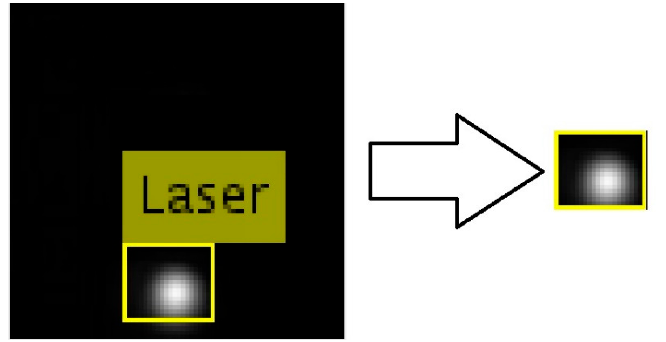
Figure 10. Incomplete light spot recognition map.